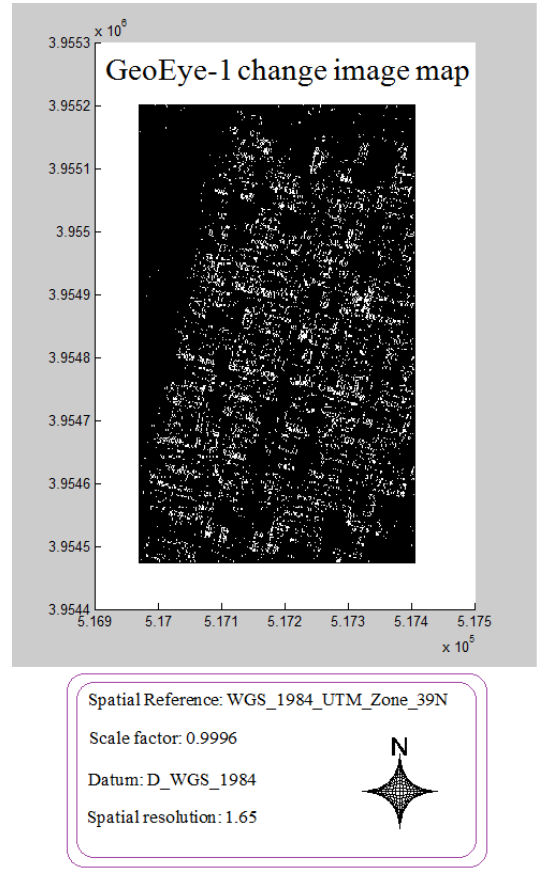
Figure 6. The produced change image map using GeoEye-1 satellite